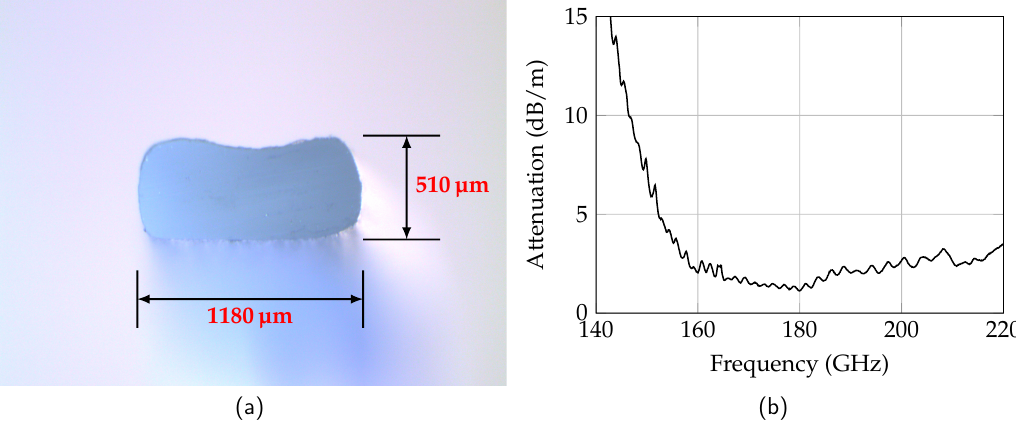
Figure 5. Cross-sectional view of the extruded dielectric waveguide (a) and the measured attenuation of the dielectric waveguide (b) .